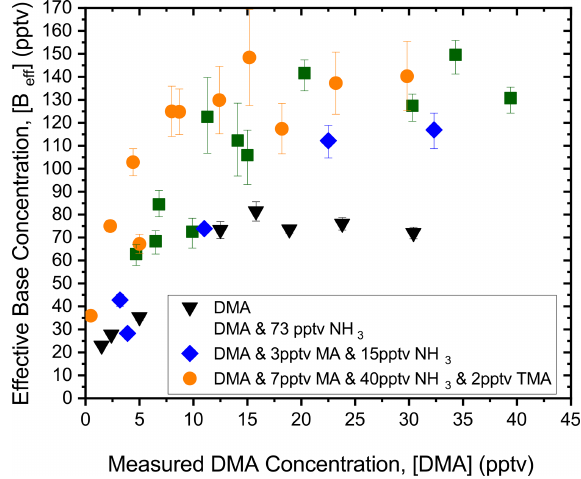
Figure 1. Comparison of effective base concentration from the NPM ([ B eff ]) with measured base concentration ([ B ]) for single- component injections of ammonia (blue squares), methylamine (red circles), dimethylamine (black triangles), and trimethylamine (green pentagons). The average sulfuric acid concentration was 1 × 10 8 cm − 3 , and the reaction time was 2s.